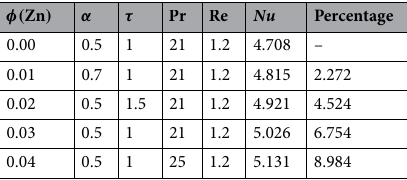
Table 5. Percentage enhancement for different volume fraction of Zn.